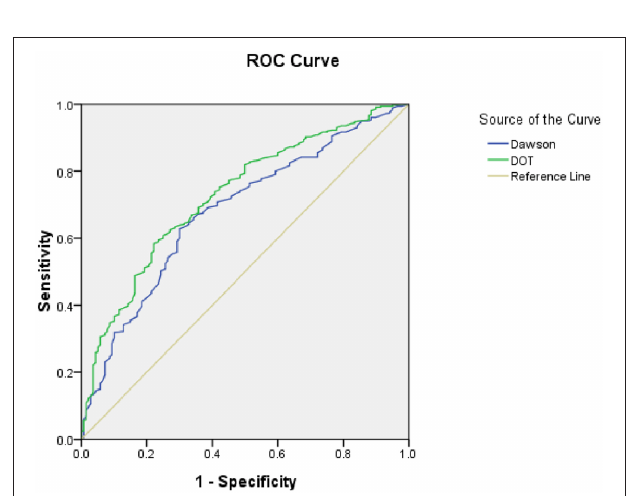
FIGURE 2 | The predictive value of Dawson and DOT score using